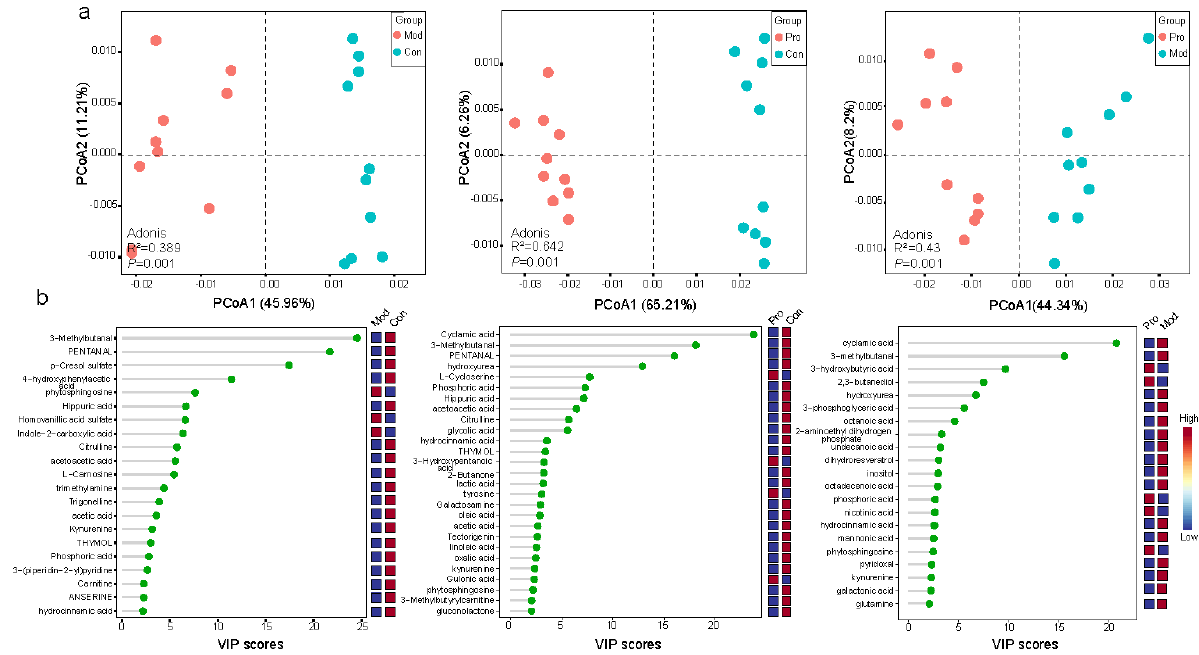
Figure 4. Comparison between the serum metabolome of the control (Con), model (Mod), and probiotic (Pro) groups at day 22. ( a ) Principal coordinates analysis (PCoA; Bray-Curtis distance) score plots of the serum metabolome between groups. ( b ) Annotated significant differential metabolites: Con versus Mod groups; Con versus Pro groups; Mod versus Pro groups, detected by liquid chromatography-mass spectrophotometry. Cut-off threshold: variable importance in projection (VIP) score > 2 and p < 0.05.